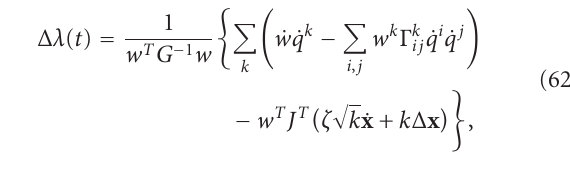
Then, it is possible to see